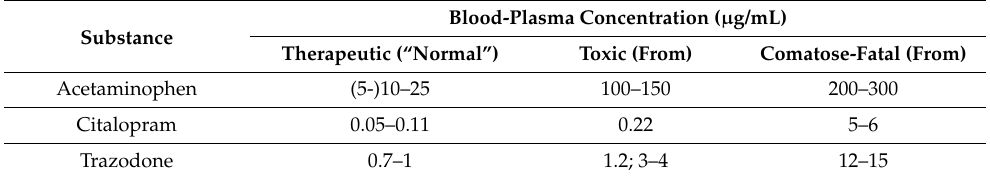
Table 3. Therapeutic, toxic and fatal blood concentrations as provided by Schulz et al.